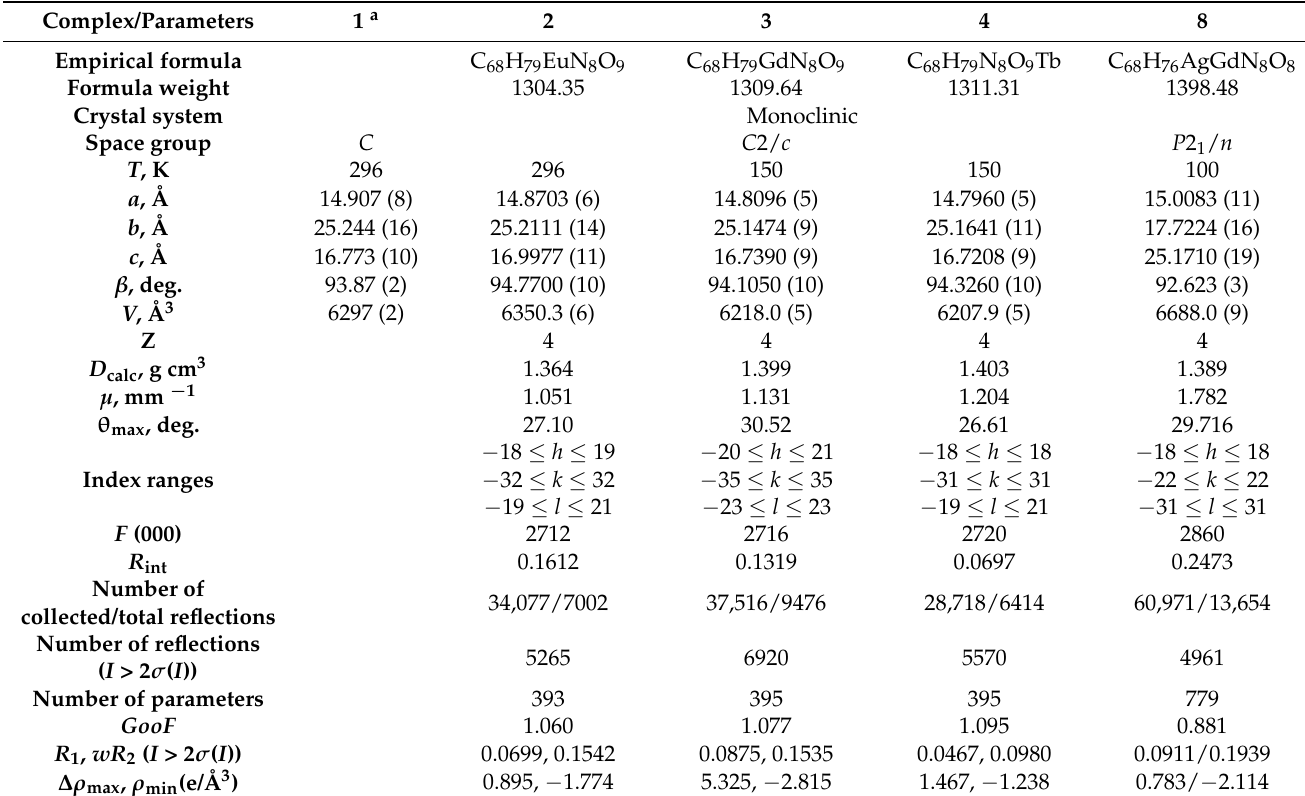
Table 1. The main crystallography data and refinement details for structures H 3 O[Ln(Q cy ) 4 ] ( 1–4 ) and [AgGd(Q cy ) 4 ] n 8